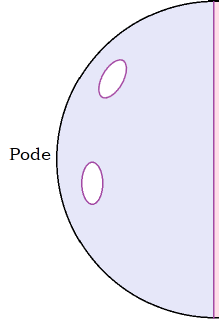
Figure 2 . The generalized horizon of the pode patch contains the cosmic horizon as the largest component, and also horizons of black holes that reside in the